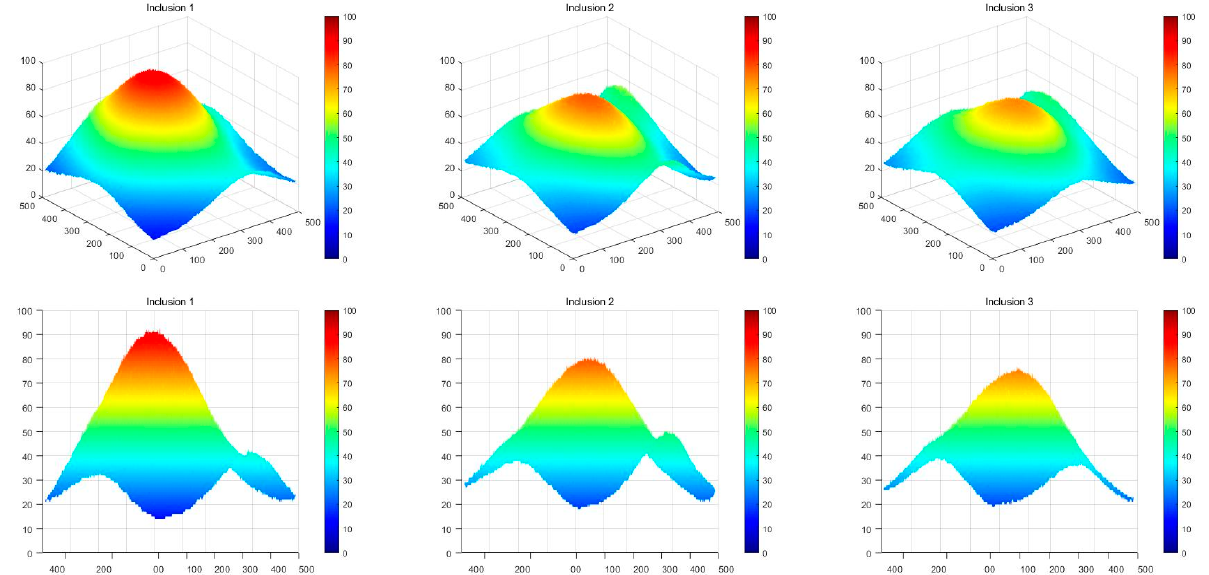
Figure 21. Three-dimensional elastic-image simulation according to the degree of elasticity.